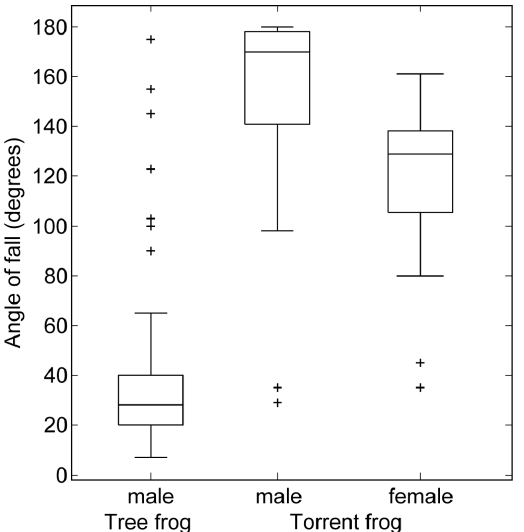
Figure 8. Attachment performance of male tree frogs ( R. pardalis ) and male and female torrent frogs ( S. guttatus ) on the 1125 mm rough surface at a high flow rate. Male data are from Figure 3. Angles of fall for female torrent frogs are significantly higher than those of male tree frogs (Mann-Whitney U-test, N ~ 14, p v 0 : 001, z ~{ 4 : 19, R ~ 255 : 5 ), but lower than those of male torrent frogs (Mann Whitney U-test, N ~ 50, p v 0 : 001, z ~ 4 : 68, R ~ 849 ).